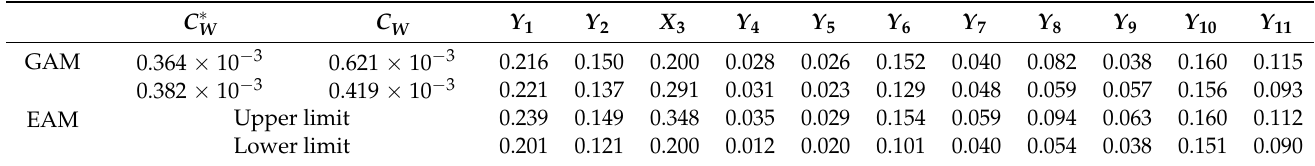
Table 5. The optimization results of the DTMB 5145.